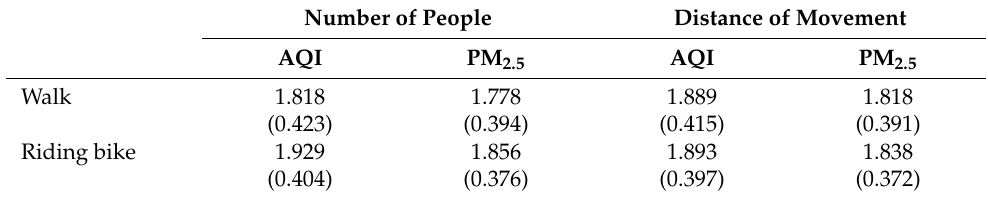
Table A19. Comparison between the Durbin-Watson statistic before and after using the PW